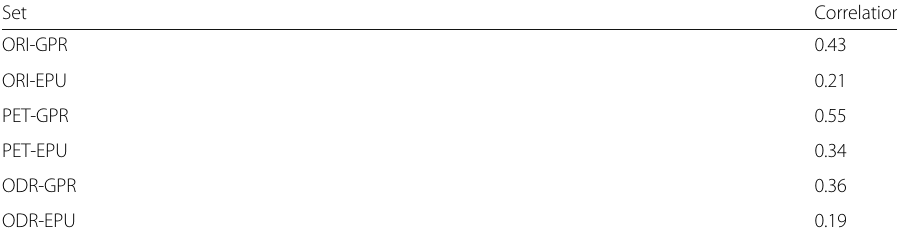
Table 7 The correlation between GPR/EPU and the equity sectors, on a monthly basis Set